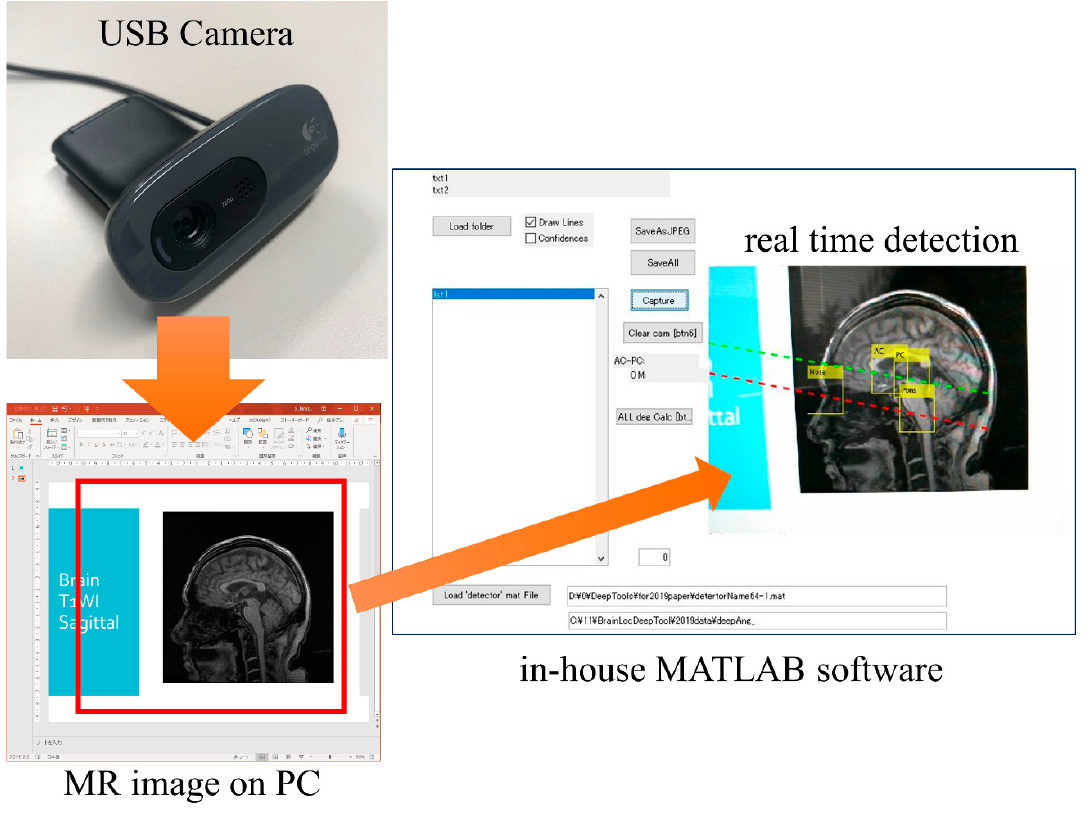
Figure A1. Example of the real time detection of the standard line for brain MRI. The red and green dotted lines indicate the OM-line and the AC-PC line, respectively.